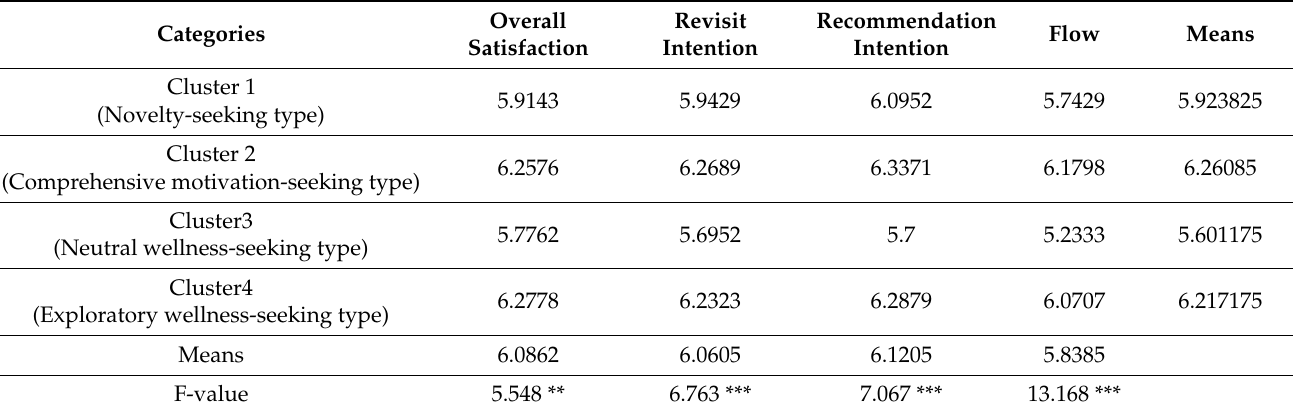
Table 12. Difference in the means of overall satisfaction, behavioral intention, and flow by wellness tourism product participant